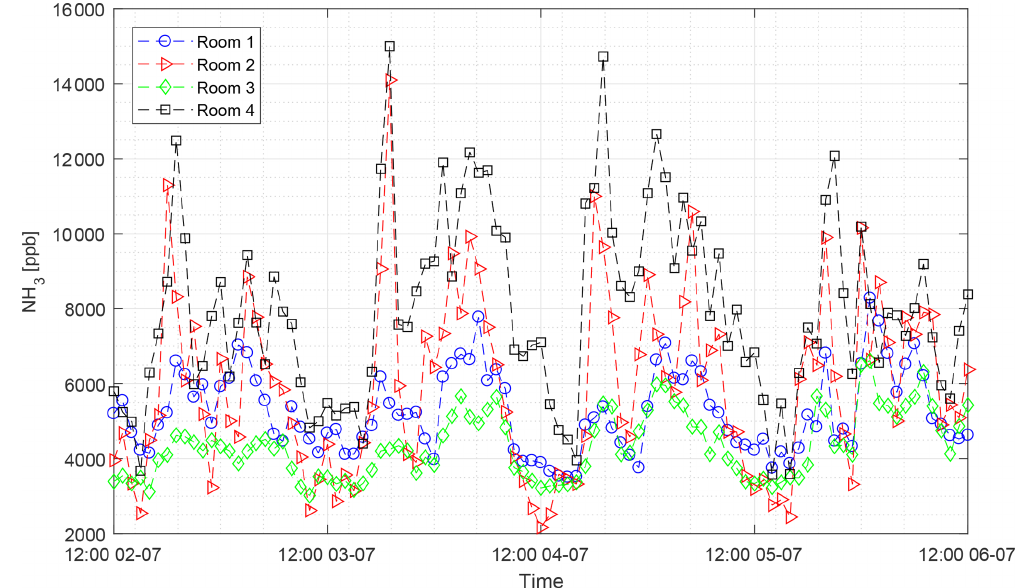
Figure A2. Hourly mean concentrations of NH 3 from four different rooms with finisher pigs.